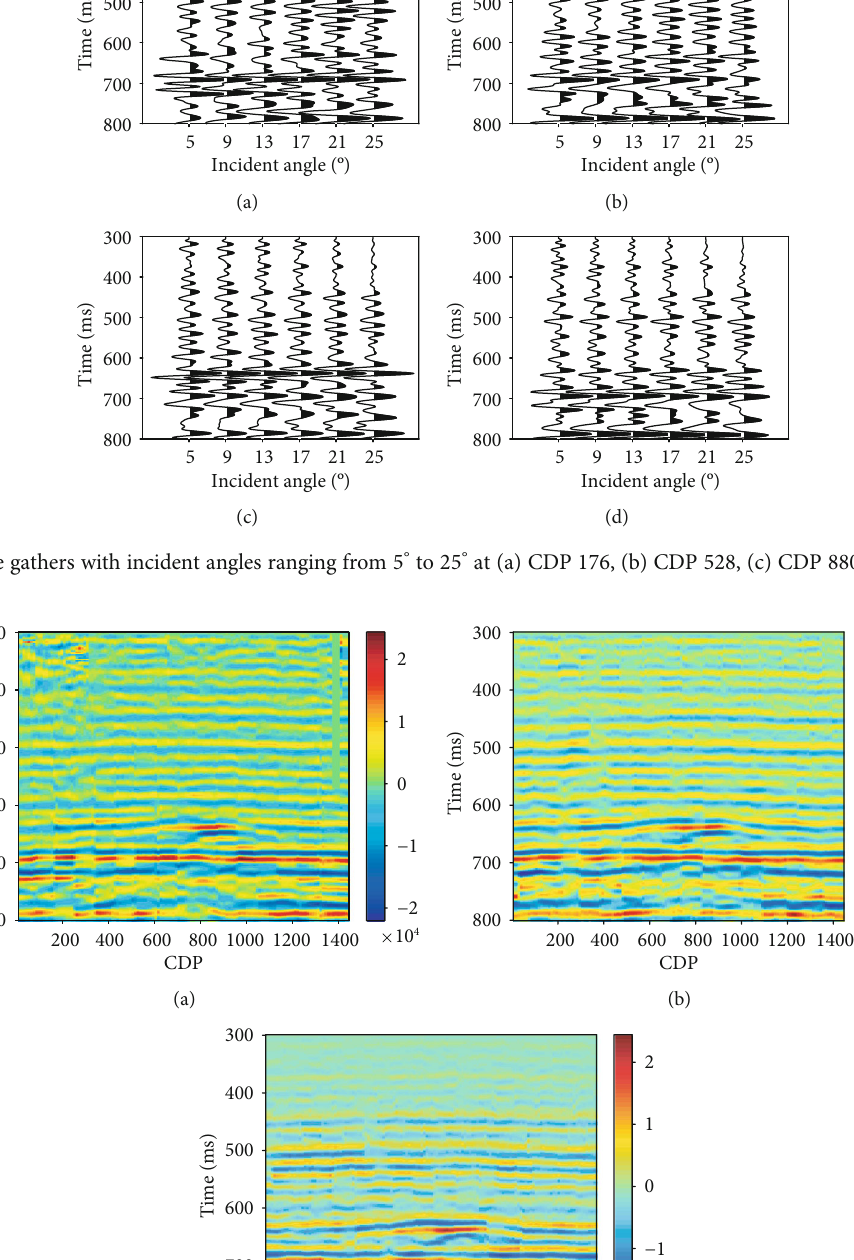
200 400 600 800 1000 1200 1400